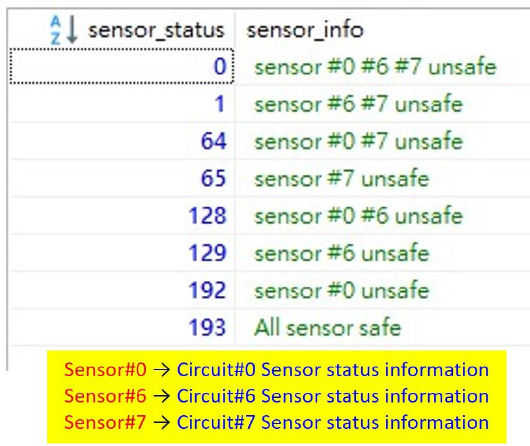
Figure 16. Eight sensor status.